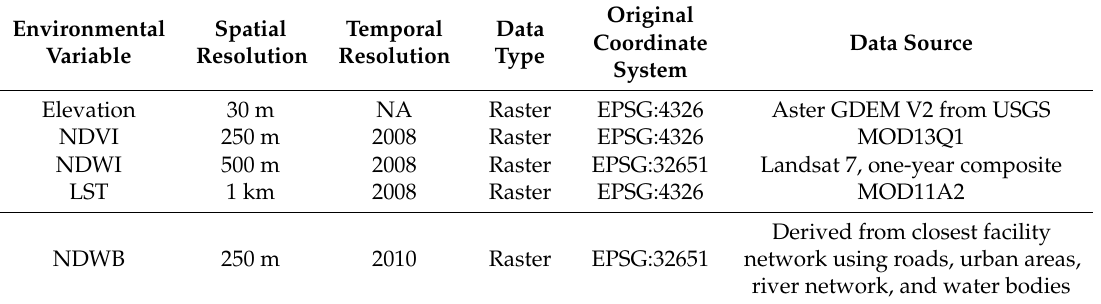
Table 1. Environmental variables